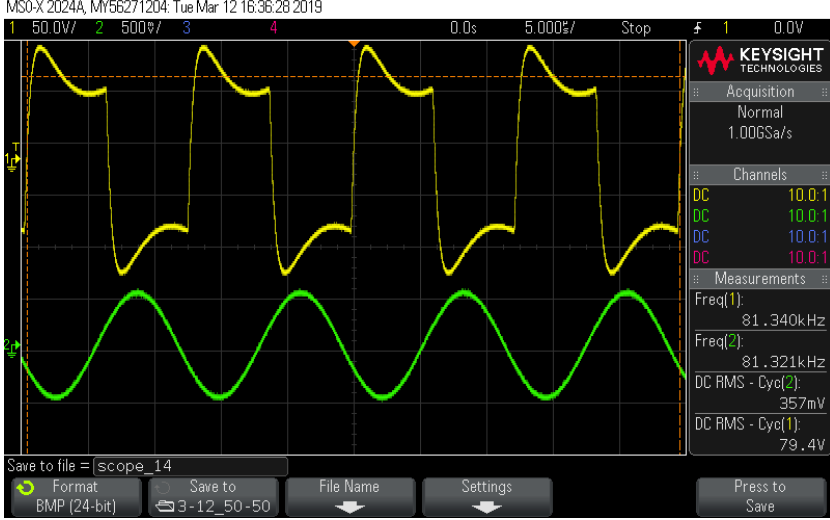
Figure 13. Experimental result of the MCR-WPT system with two intermediate coils—when α = β = 0.2, and the transfer distance is 0.5